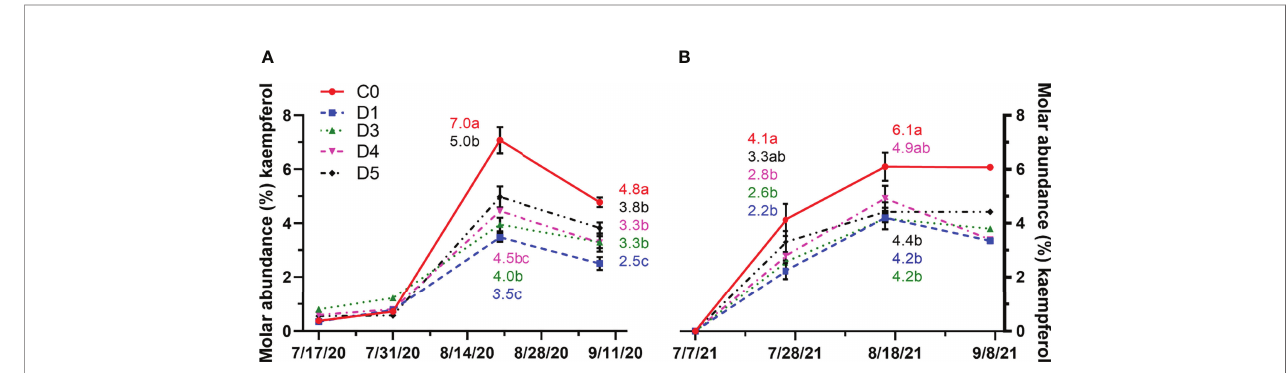
FIGURE 8 | Molar abundance (%) of kaempferol throughout the growing season in (A) 2020 and (B) 2021 for untreated vines (C0) and vines under shade fi lm treatments (D1, D3, D4. D5). Points are means ± standard error ( n = 4). Means with no letters in common are signi fi cantly different (p ≤